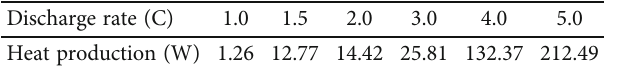
Table 3: Heat production rate of LiFePO discharge